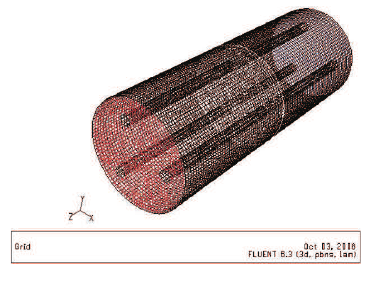
Figure 7. Pressures in 3 cross-section.